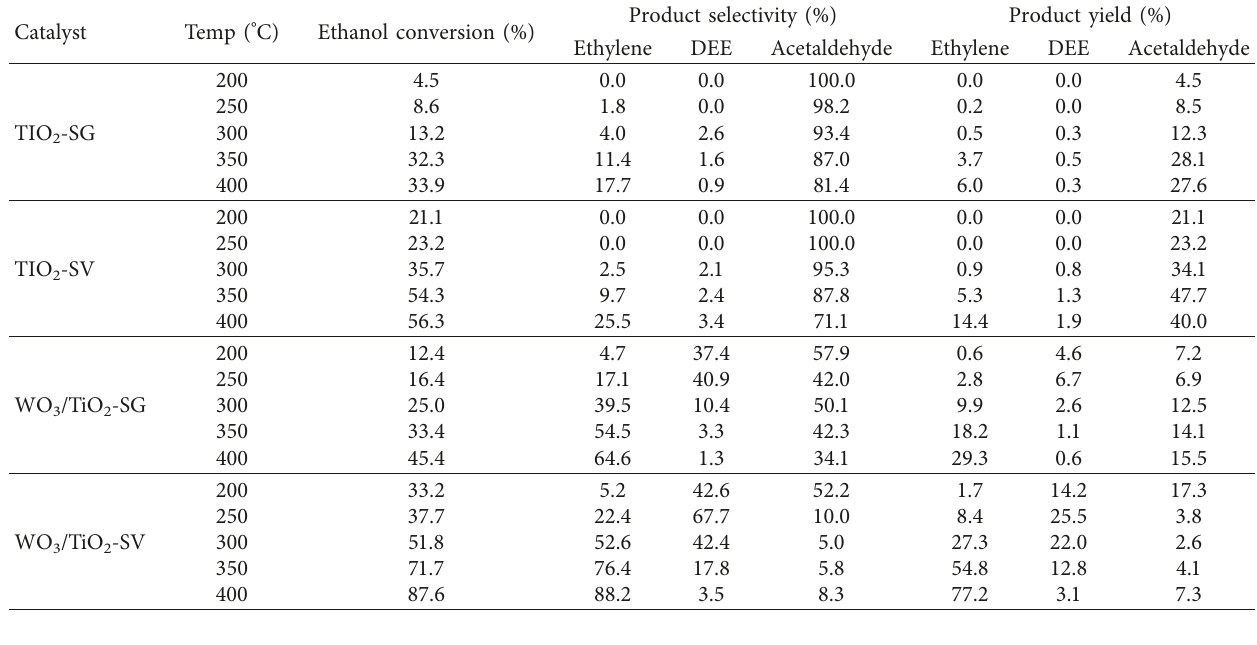
Table 6: Ethanol conversion, product selectivity, and product yield as a function of reaction temperature (the reaction condition: T 200–400 ° C, WHSV (cid:28)